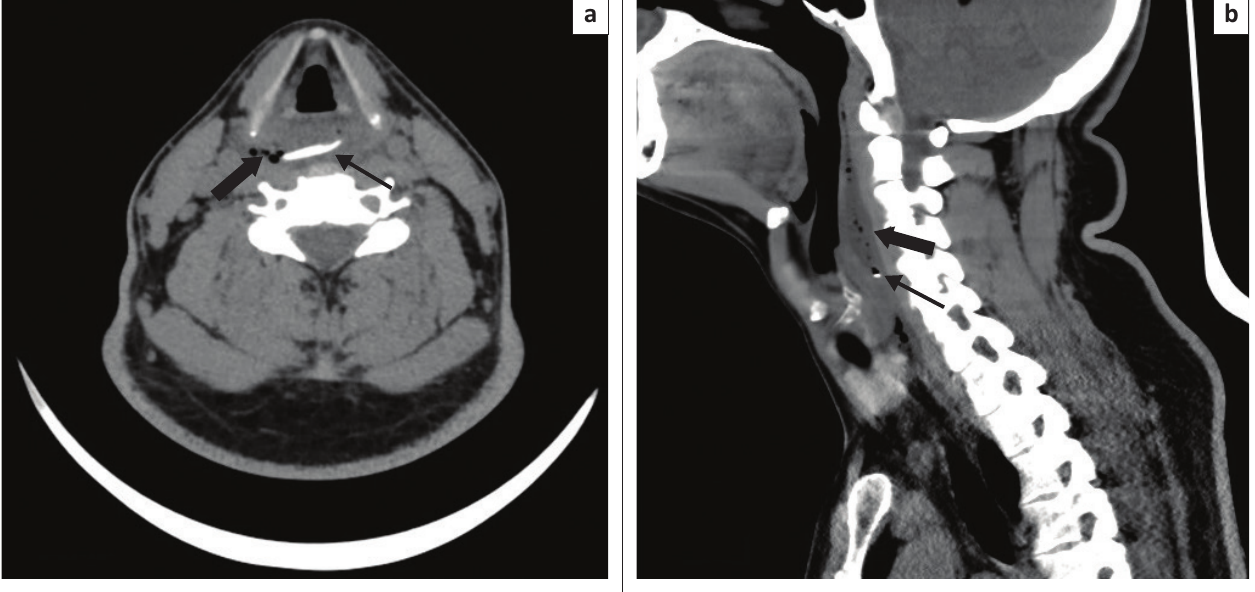
FIGURE 2: Axial (a) and sagittal reformatted (b) computed tomography images showing a 4 cm × 1 cm fish bone (thin arrows) impacted in the posterior cricopharyngeal wall with perforation resulting in a retropharyngeal abscess (thick